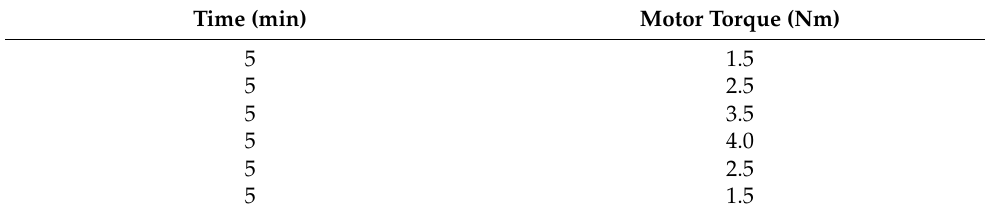
Table 9. Test values.